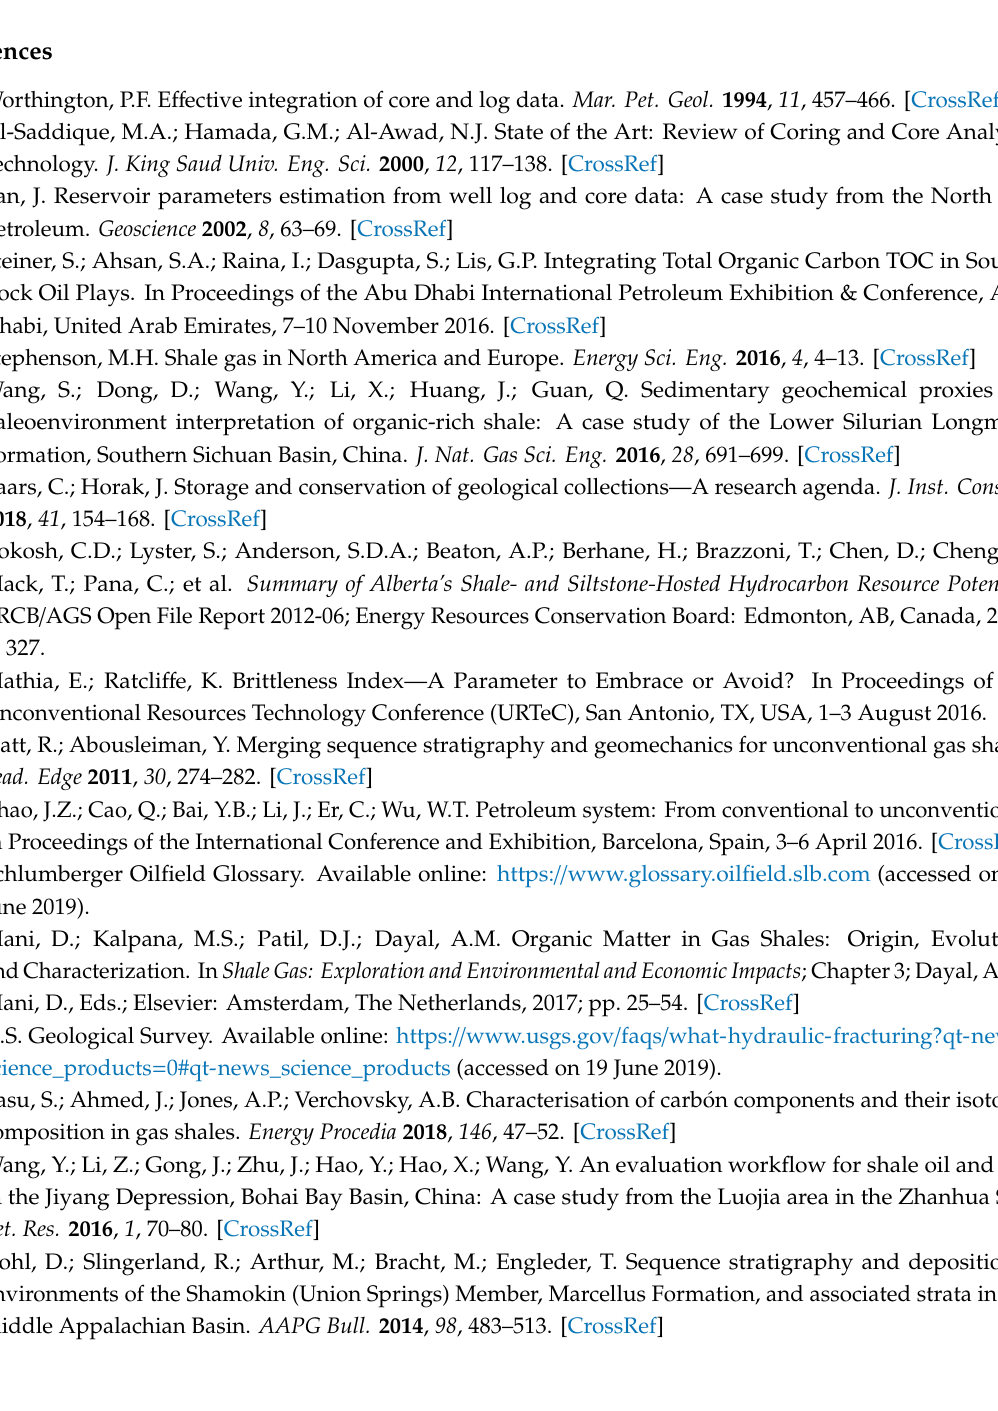
Figure S1: Cartoon (not to scale) depicting hydrocarbon systems (conventional and